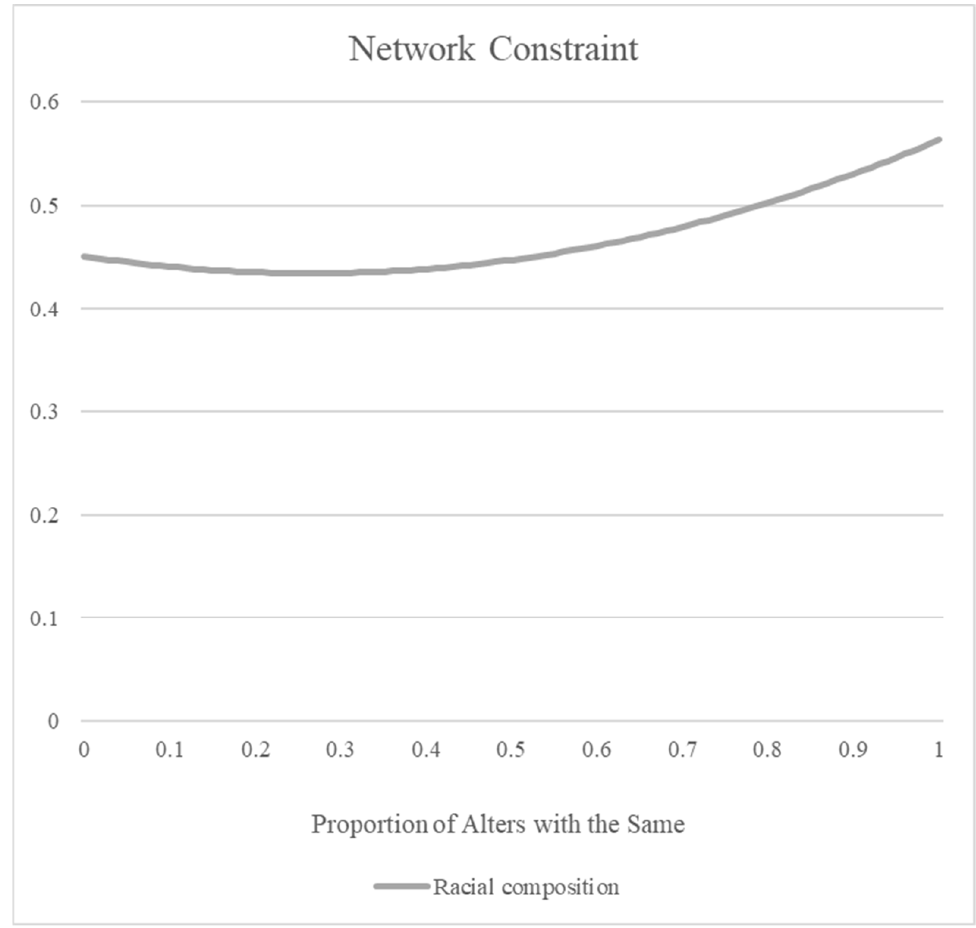
Figure 4. Predicted network constraint by homophily by racial composition for congregations with at least two participating alters. at least two participating